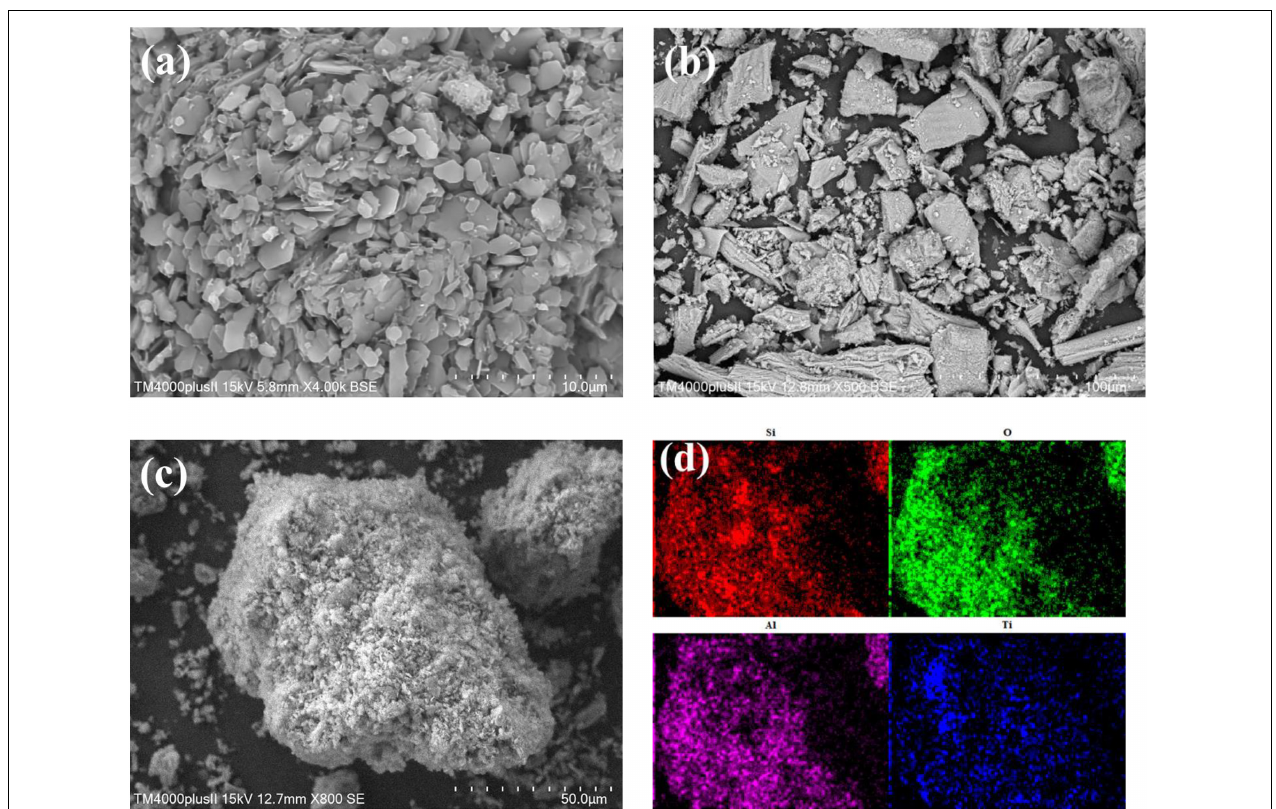
FIGURE 3 | Micro-morphology: (a) SEM of zeolite; (b) SEM of TiO 2 ; (c) SEM of 500-TZ; (d) elements distribution of 500-TZ.